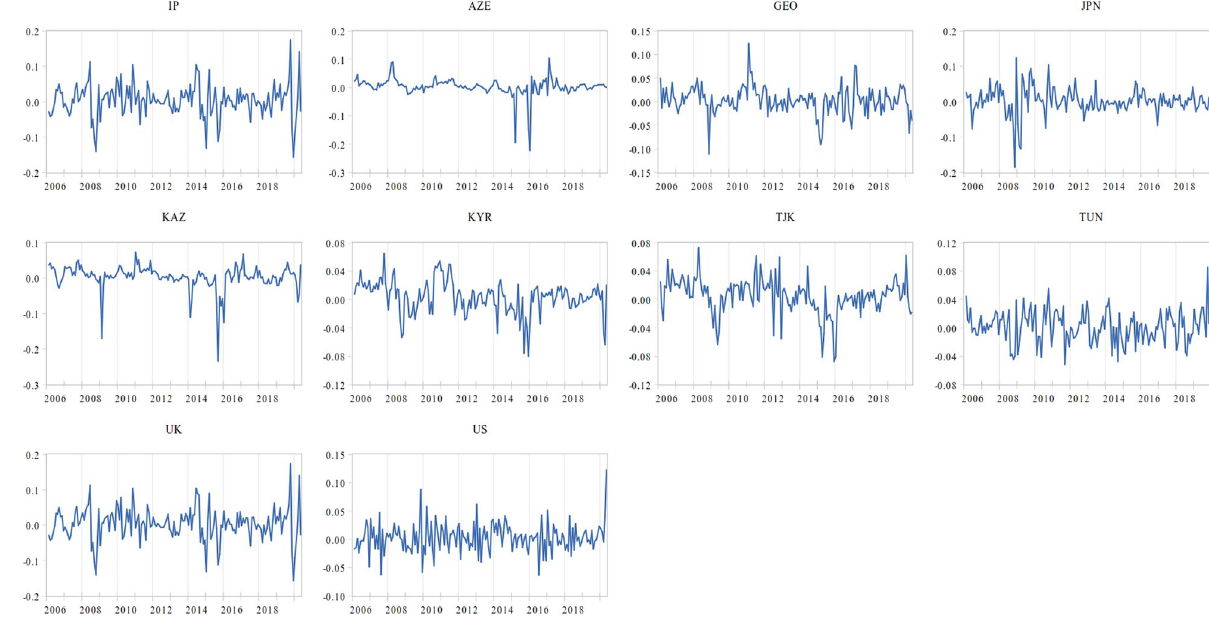
Fig. 1 Time-series plots of monthly beef price returns. Table 2 Unit root